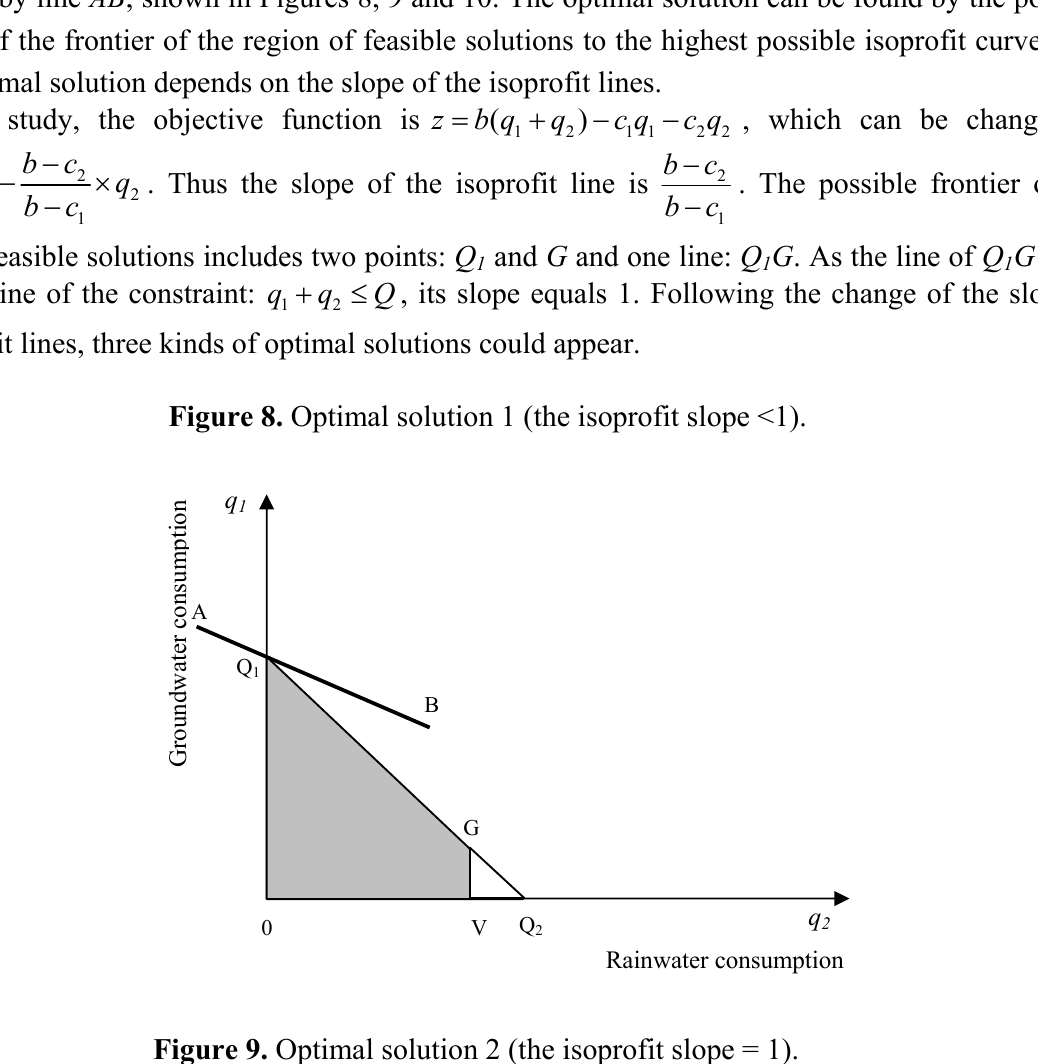
Figure 9. Optimal solution 2 (the isoprofit slope =